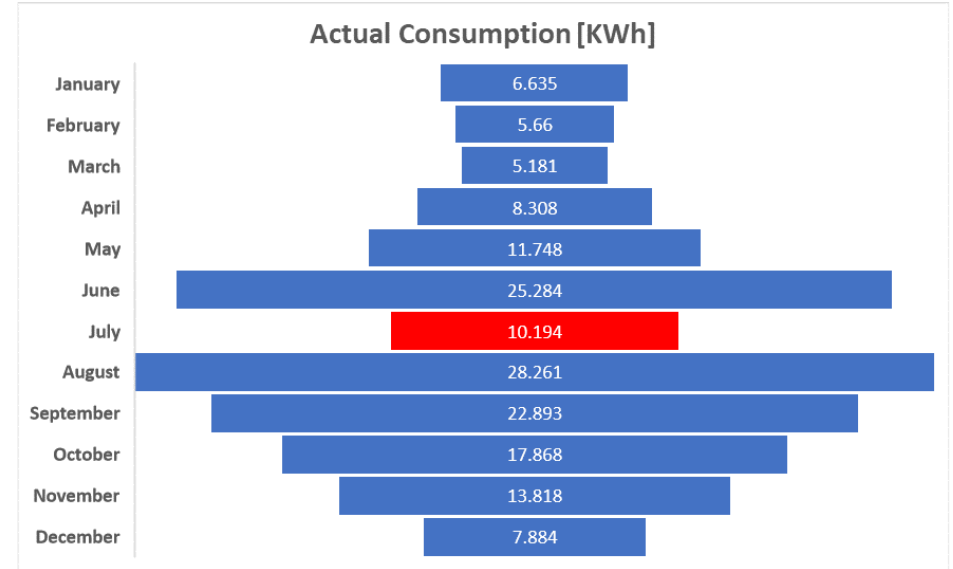
Figure 3. Example of Qatari Home Daily Electrical Consumption in Each Month .